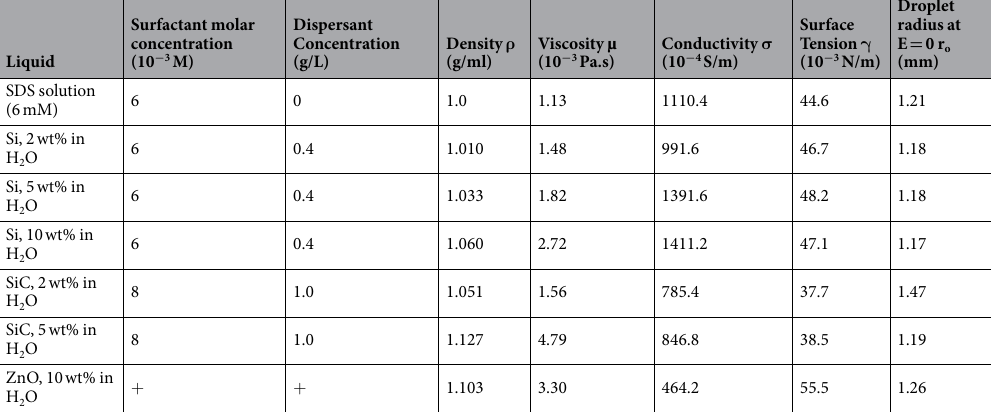
Table 1. Physical properties of nanoparticle solutions in DI water. Note: Si and SiC nanoparticles are 30 nm in diameter and ZnO nanoparticles are 70 nm in diameter. All nanosuspensions are in water. ( + ) obtained from commercial suspension (Alfa aeser, product number